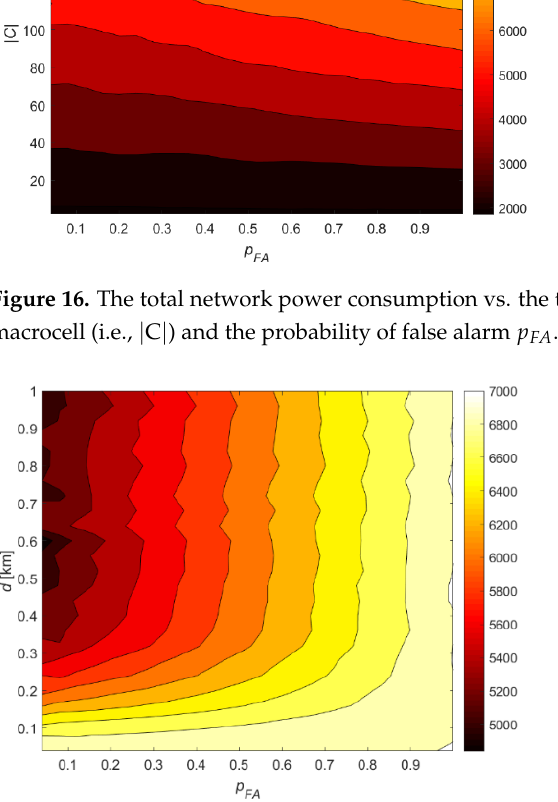
Figure 17. The total network power consumption vs. the maximum allowable D2D distance 𝑑 and the probability of false alarm 𝑝 𝐹𝐴 .